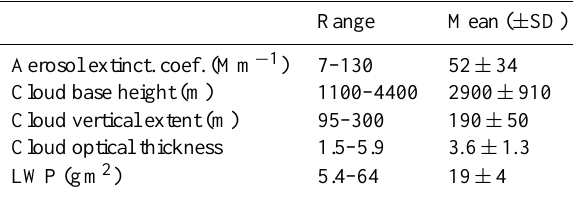
Table 2. Aerosol and cloud properties of 29 studied aerosol–cloud scenarios. The range of observed aerosol extinction coefficients and cloud optical thicknesses and the corresponding mean value and standard deviation (SD) are given for 532nm